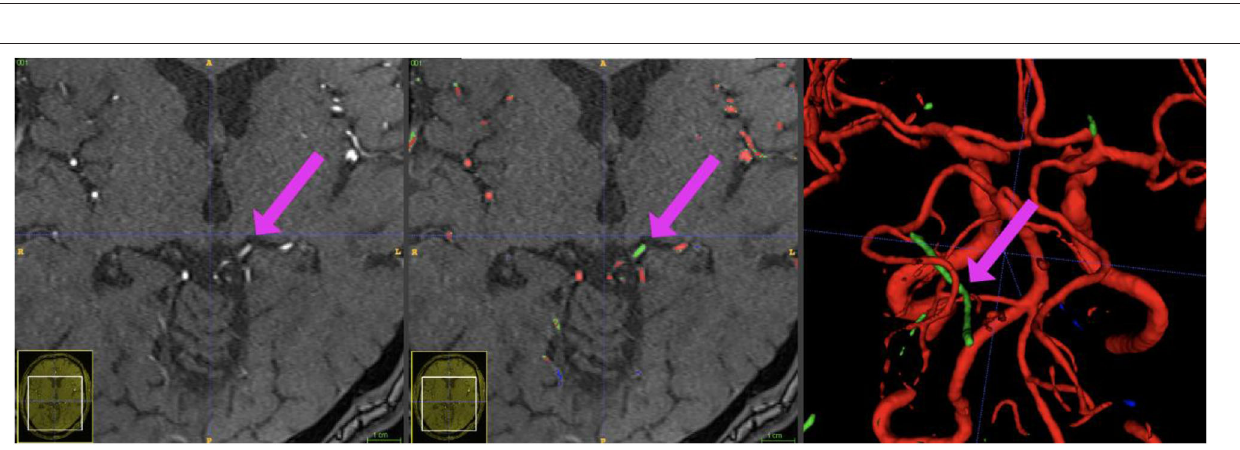
FIGURE 6 | Vessel segmentation of an example patient. Two slices are shown (A,B) . True positive and false positive are shown in red and green, respectively. The patient had hyperintense proteinaceous fluid in the sinuses (purple and orange arrows) indicative of chronic sinusitis and an extranial vessel (yellow arrow), which were all false positively labeled in the plain Unet (column 2). It is evident that the network needs high contextual anatomic knowledge to distinguish the hyperintense roundish sinusitis structures from vessels. Also, this example illustrates how close—anatomically—extracranial vessels can be located to brain-supplying vessels (correctly labeled by all networks). For the structure labeled by the purple arrow, only the BRAVE-NET network correctly classifies the majority of voxels as non-vessels (purple star). For the larger structure which is less hyperintense and further away from brain areas as well as the extracranial vessel, the Context-net alone correctly classified the structures (orange and yellow asterisks). This example illustrates that while the overall differences between the models do not seem large, in certain pathological cases the contextual information proves crucial to avoid false positive segmentation results.